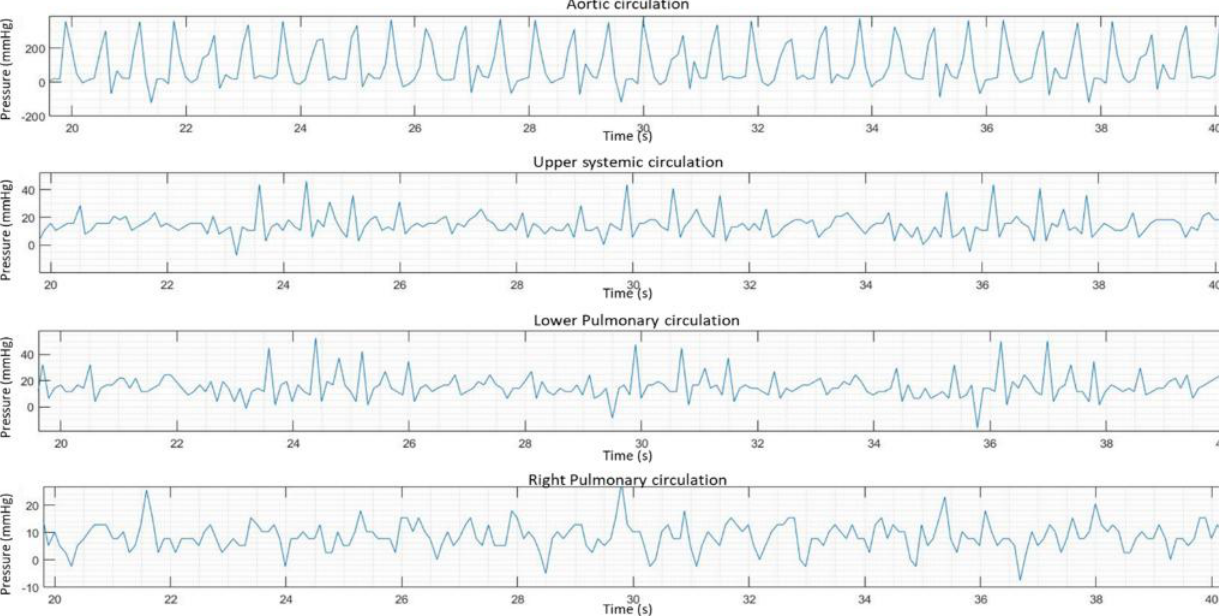
Figure 12. Unfiltered Pressure waveform for 3 mm IJS experiment.